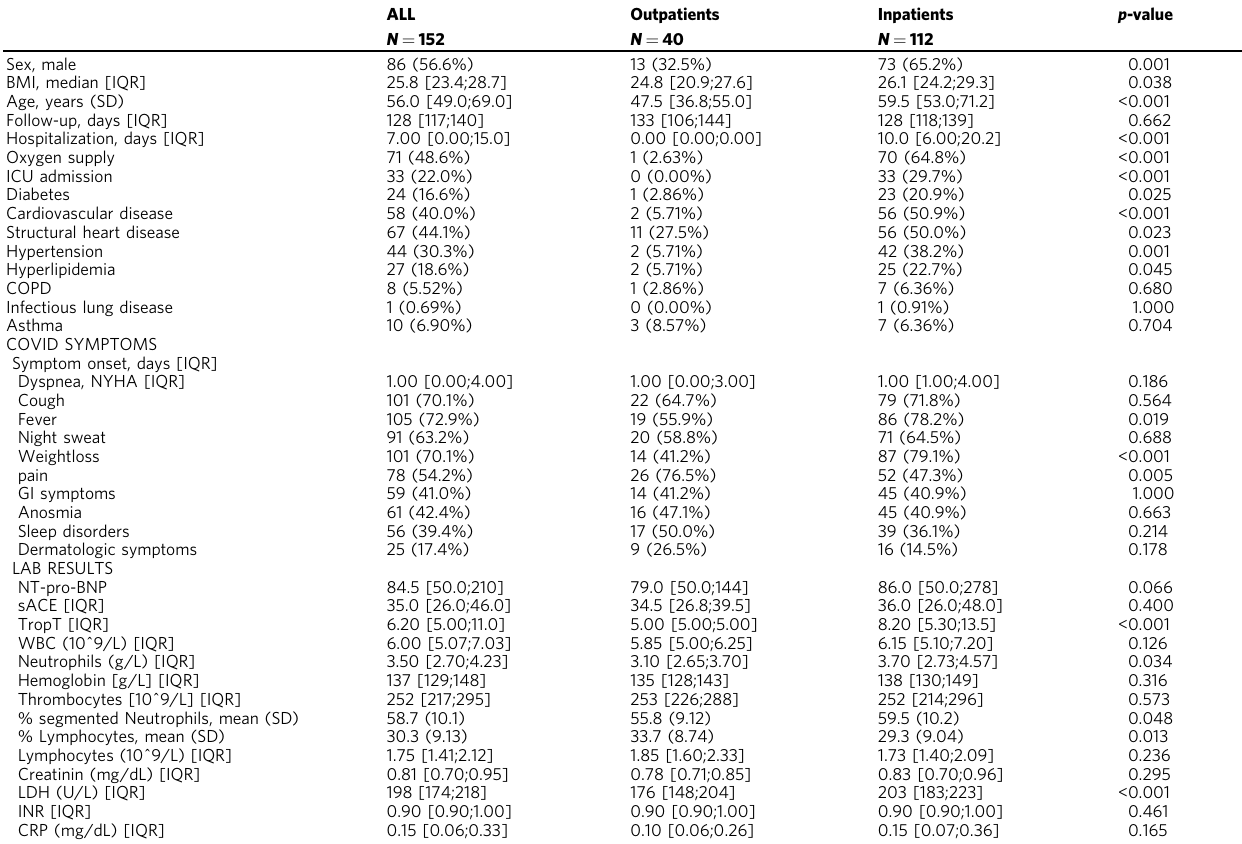
Table 1 Clinical characteristics such as demographics, comorbidities, medication, and laboratory results of the CovILD Cohort. ALL Outpatients Inpatients p -value N = 152 N = 40 N = 112 Sex, male